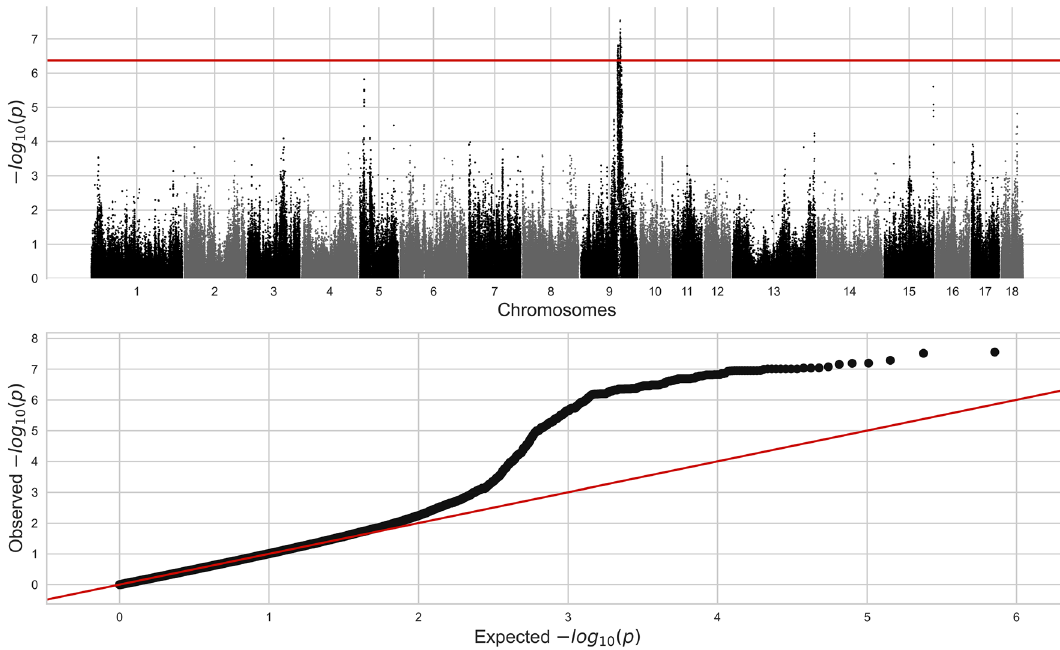
Figure 1. Manhattan (top) and Q-Q (bottom) plots of GWAS